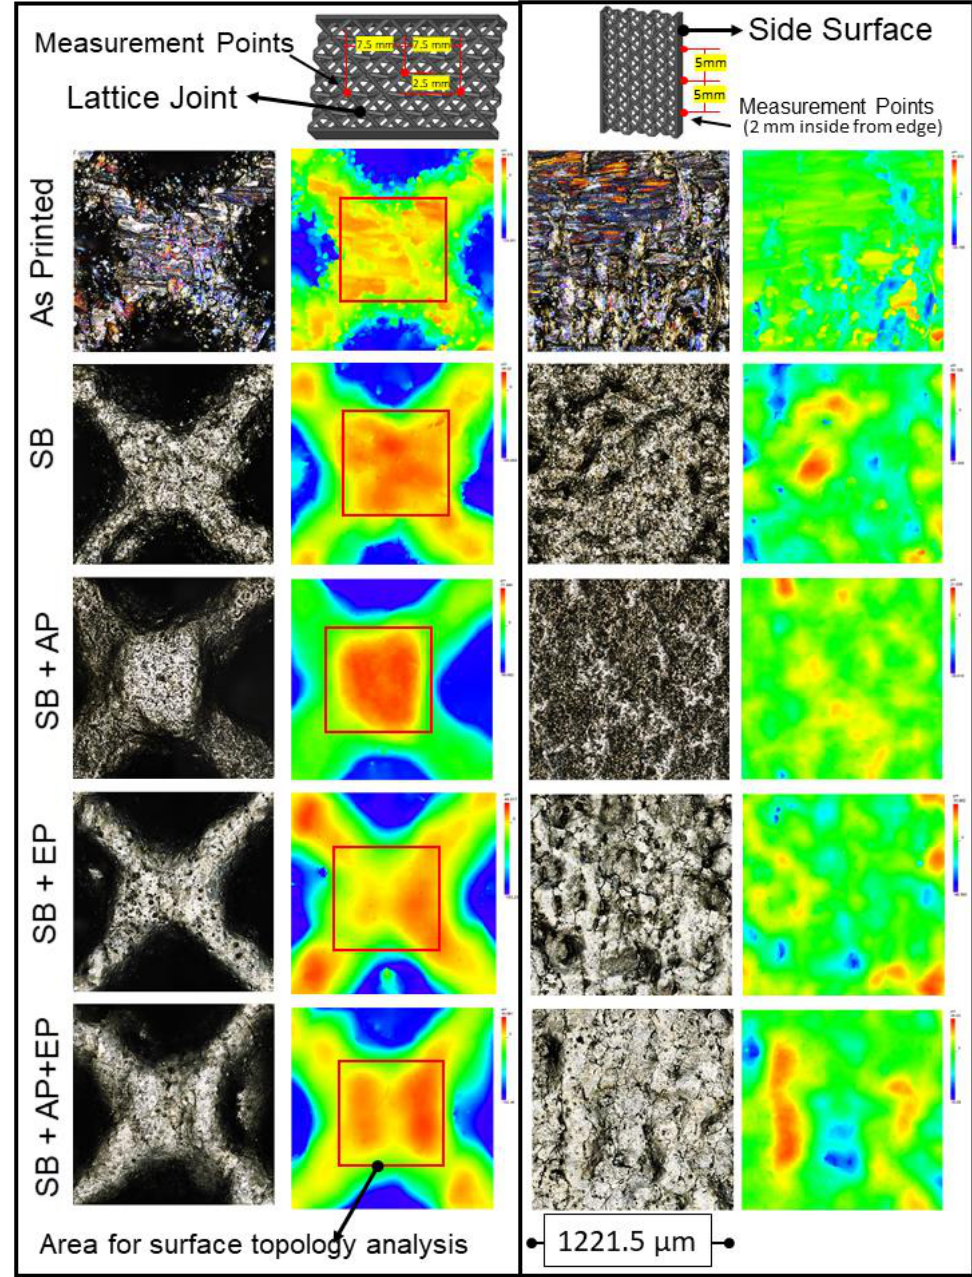
Figure 18. Surface topography measurements following the various combinations of sequential post-processing of the metal lattices. (SB: sandblasting, AP: abrasive polishing, EP: electropolish- ing.).